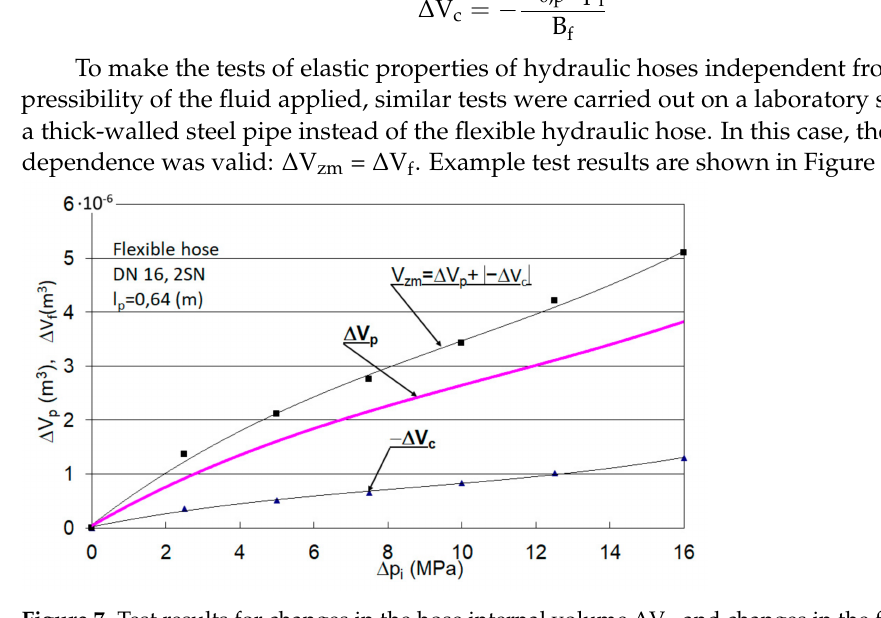
Figure 7. Test results for changes in the hose internal volume ∆ V p and changes in the fluid volume ∆ V ∆ p i in the hose. f vs. internal pressure